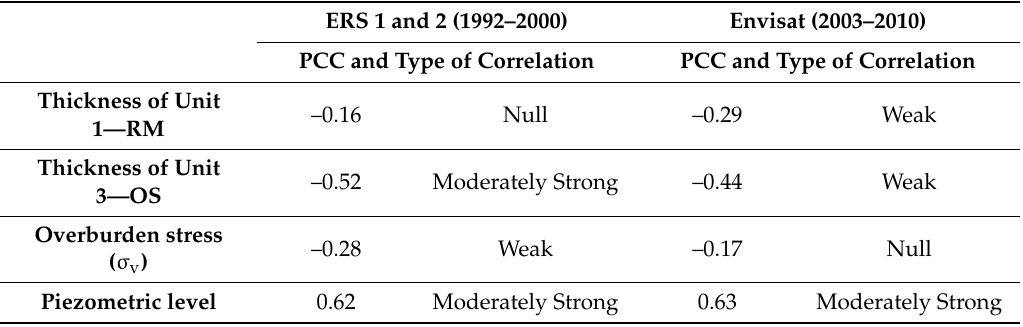
Overburden stress